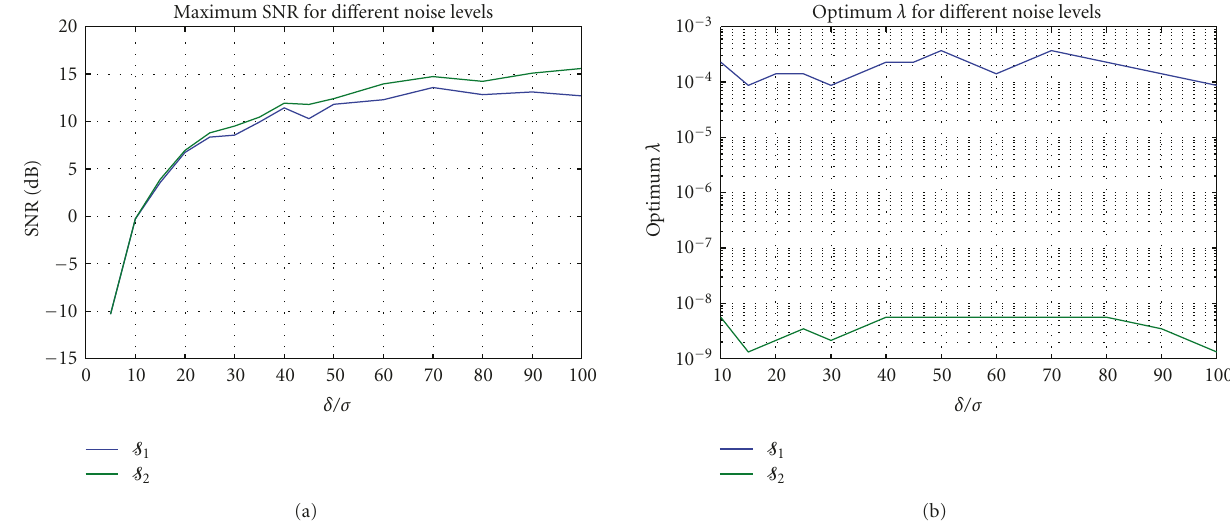
Figure 6: (a) Maximum SNR over all possible values of the smoothing parameter λ for a fixed noise level δ/σ . (b) Optimal value of the parameter λ for which the recovered stimuli attain the maximum SNR. Blue line for S 1 and green line for S 2